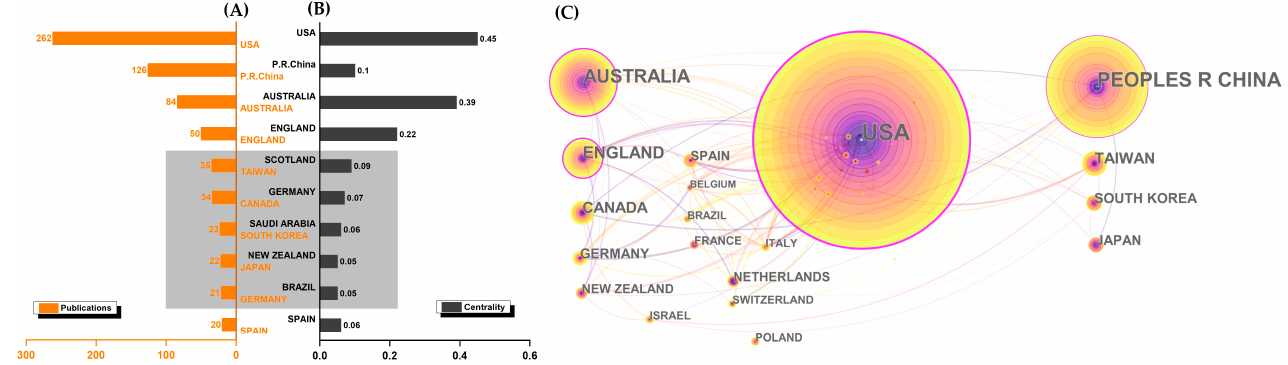
Figure 3. Visualized map of the leading countries and regions. ( A ) Top ten countries and regions by publications; ( B ) top ten countries and regions by centrality; ( C ) cooperation map of countries and regions.